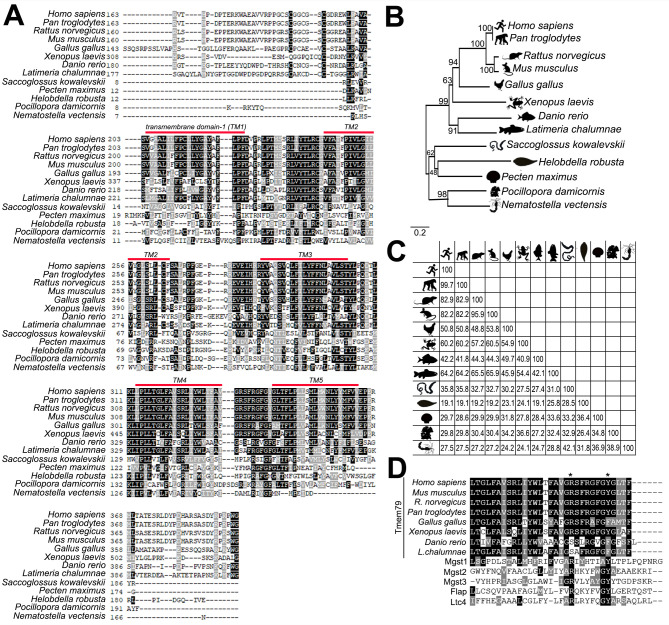
Evolutionary comparison of Tmem79 proteins in vertebrates, protostomes, and cnidarians.(A) ClustalW alignment of TMEM79/Tmem79 proteins from human (Homo sapiens), chimpanzee (Pan troglodytes), rat (Rattus norvegicus), mouse (Mus musculus), chicken (Gallus gallus), frog (Xenopus laevis), zebra fish (Danio rerio), coelacanth (Latimeria chalumnae), hemicordate (Saccoglossus kowalevskii), great scallop (Pecten maximus), leech (Helobdella robusta), cauliflower coral (Pocillopora damicornis), and sea anemone (Nematostella vectensis). Black and grey represent identical and conservative amino acid residues, respectively. Note that the amino terminus before the transmembrane domain 1 (TM1) is poorly conserved and shown only partially. The predicted Tmem79 of Nematostella vectensis appears to lack the 5th transmembrane domain (TM5) that is present in other species listed. Accession numbers for the Tmem79 sequences in the alignment are listed in Materials and methods section. (B) The phylogenetic tree showing homology among Tmem79 proteins from species presented in A based on Neighbor-Joining phylogenetic methods. Distances in the cladogram are derived from amino acid substitutions. (C) Orthologous comparisons of identity of Tmem79 proteins among species listed in A using ClustalW alignment. (D) ClustalW alignment of vertebrate TMEM79/Tmem79 proteins from human, chimpanzee, rat, mouse, chicken, frog, zebra fish, and coelacanth with mouse MAPEG family members Mgst1, Mgst2, Mgst3, Flap and Ltc4s (Emrick et al., 2018; Saunders et al., 2013). Asterisk indicates two conserved residues within the region of limited sequence similarity corresponding to mouse Tmem79 R332 and Y339.